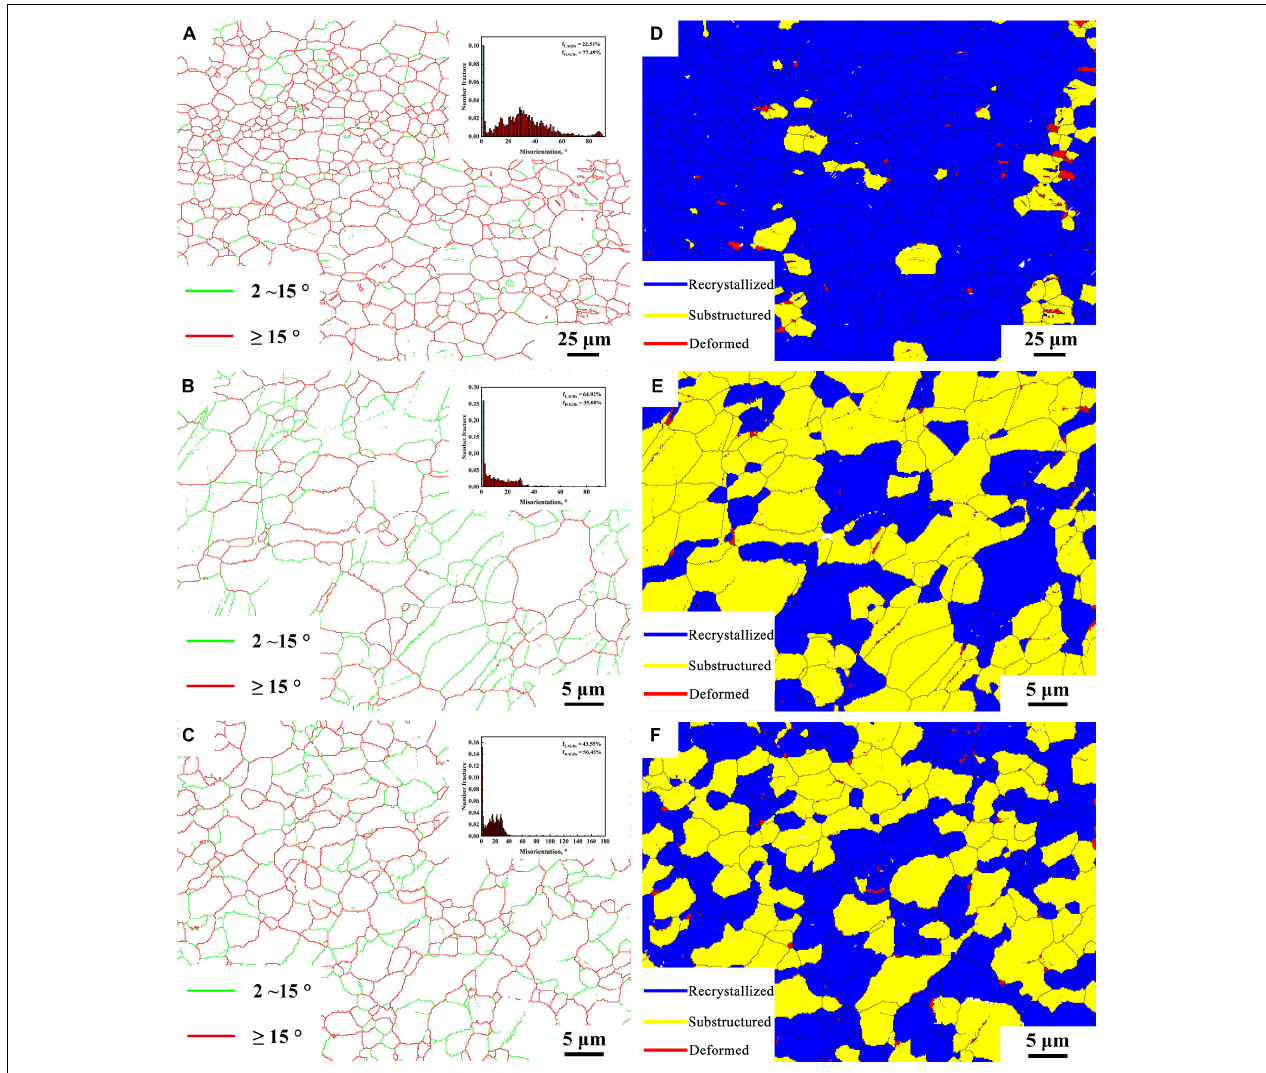
FIGURE 4 | The grain boundary map: (A) BM, (B) FSP, (C) FSP-ZrO 2 ; and recrystallized grain distribution map: (D) BM, (E) FSP, (F) FSP-ZrO 2